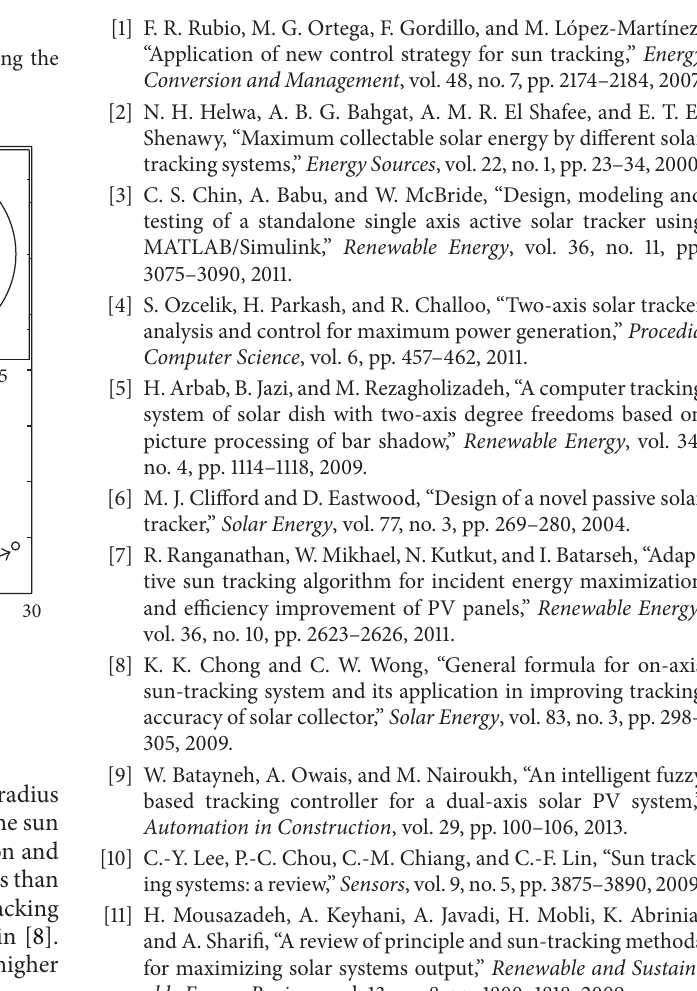
pushed the center of the sun spot into a circle with a radius of 0.6 pixels. This value is corresponding to 0.1432 ∘ of the sun rays incident angel, according to the webcam resolution and geometry of the imaging devise. So, tracking error is less than 0.15 ∘ . An open-loop solar tracker that provides a tracking error in the range from 0.236 ∘ to 0.693 ∘ is presented in [8]. So, the closed-loop system presented in this work has higher precision than the open-loop